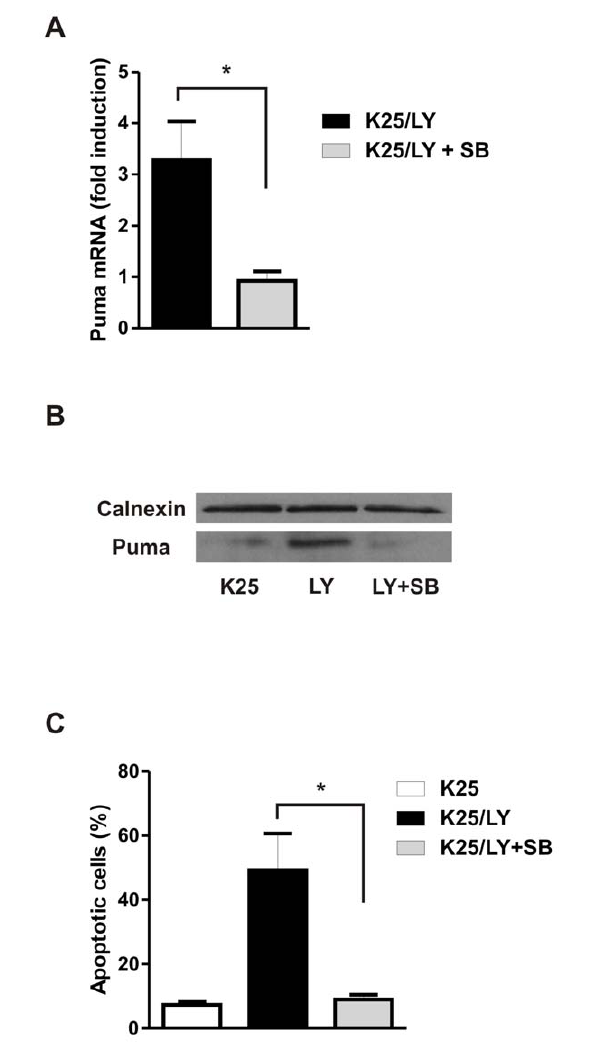
Figure 8. AKT inactivation induces Puma expression and neuronal apoptosis via a GSK3 b -dependent mechanism. CGNs maintained for 7 days in high potassium medium were treated with or without the PI3K inhibitor LY294002 (30 m M, LY) in the presence or absence of the GSK3 b inhibitor SB415286 (30 m M, SB). A, RNA was collected 8 hours post treatment and Puma mRNA levels were determined by qRT-PCR (n=3,* p , 0.05). B, Protein extracts were collected 12 hours post-treatment and Puma protein levels were analyzed by western blot. C, The fraction of apoptotic neurons was quantified after 24 hours by Hoechst staining (n=3, *p ,